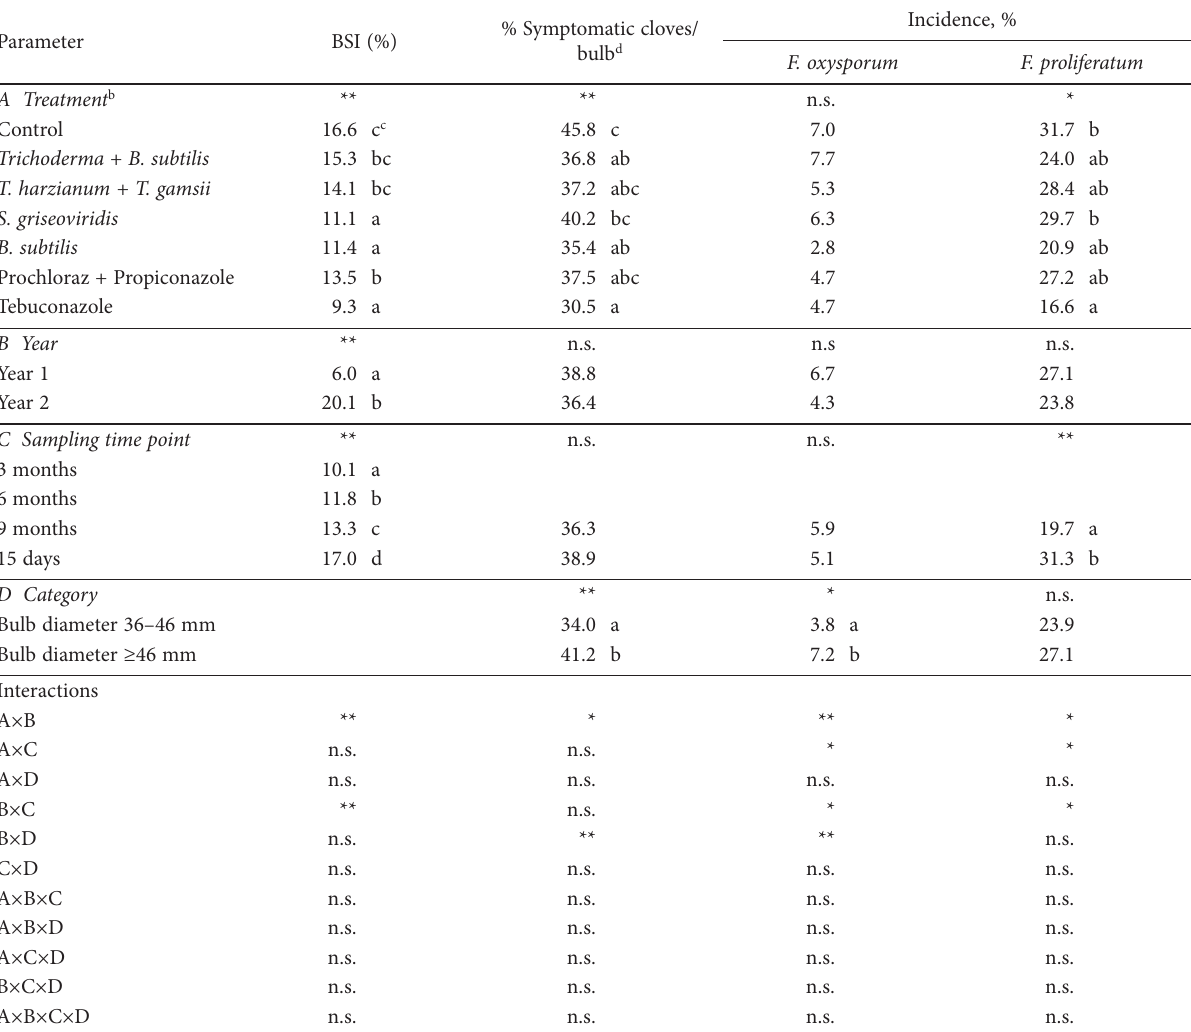
Table 4. Mean garlic disease severity indices (BSI), percentages of symptomatic cloves/bulbs and mean incidence of fungi isolated garlic cloves, for different field trial treatments, two growing seasons (Year 1, 2017–2018, and Year 2, 2018–2019), and field crop and postharvest sampling time points a . †